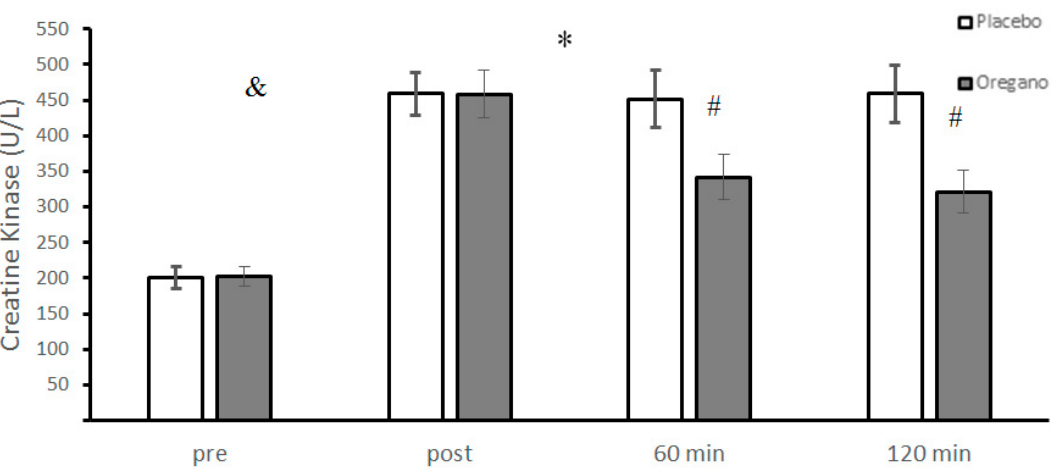
Figure 2. Mean ± standard deviations (SD) of plasma CK levels before and at different times after consuming oregano supplements. The asterisk (*) indicates significant time × group interaction, (#) indicates a significant difference between the two groups, and (&) indicates the main effect of time ( p < 0.05).